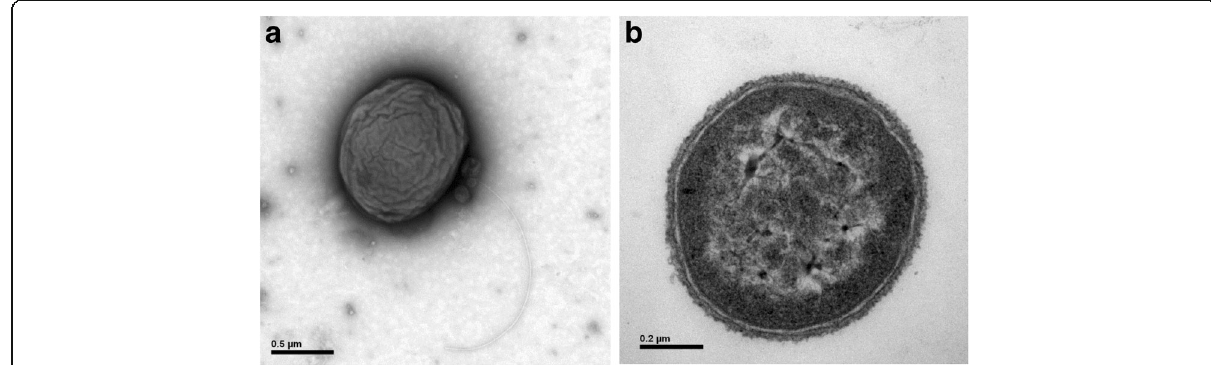
Fig. 1 Transmission electron microscopy showing the cell morphology ( a ) and ultrastructure ( b ) of Croceicoccus marinus E4A9 T . The flagella are present. Bars represent scales of 0.5 μ m ( a ) and 0.2 μ m ( b ), respectively